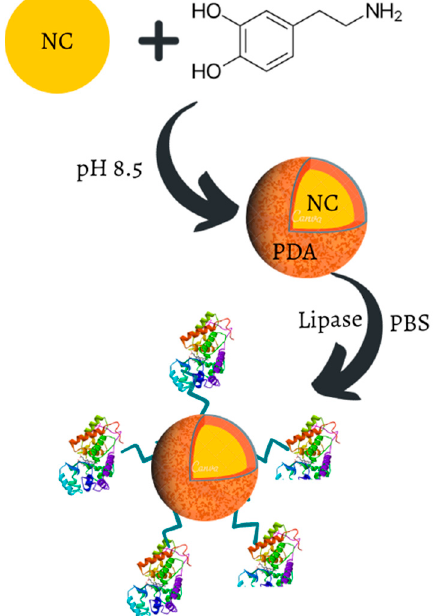
Figure 1. Schematic presentation of enzyme immobilization on PDA-coated nanoparticles .